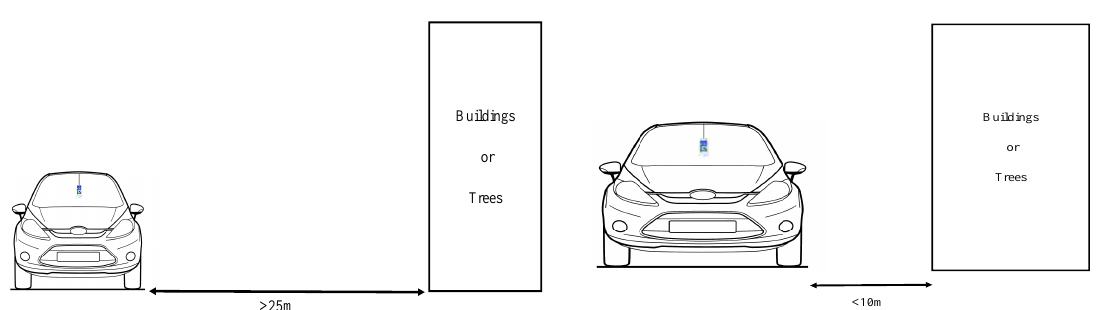
Figure 8. Condition 2, car is partially shaded at certain times and located less than 10 m from any buildings